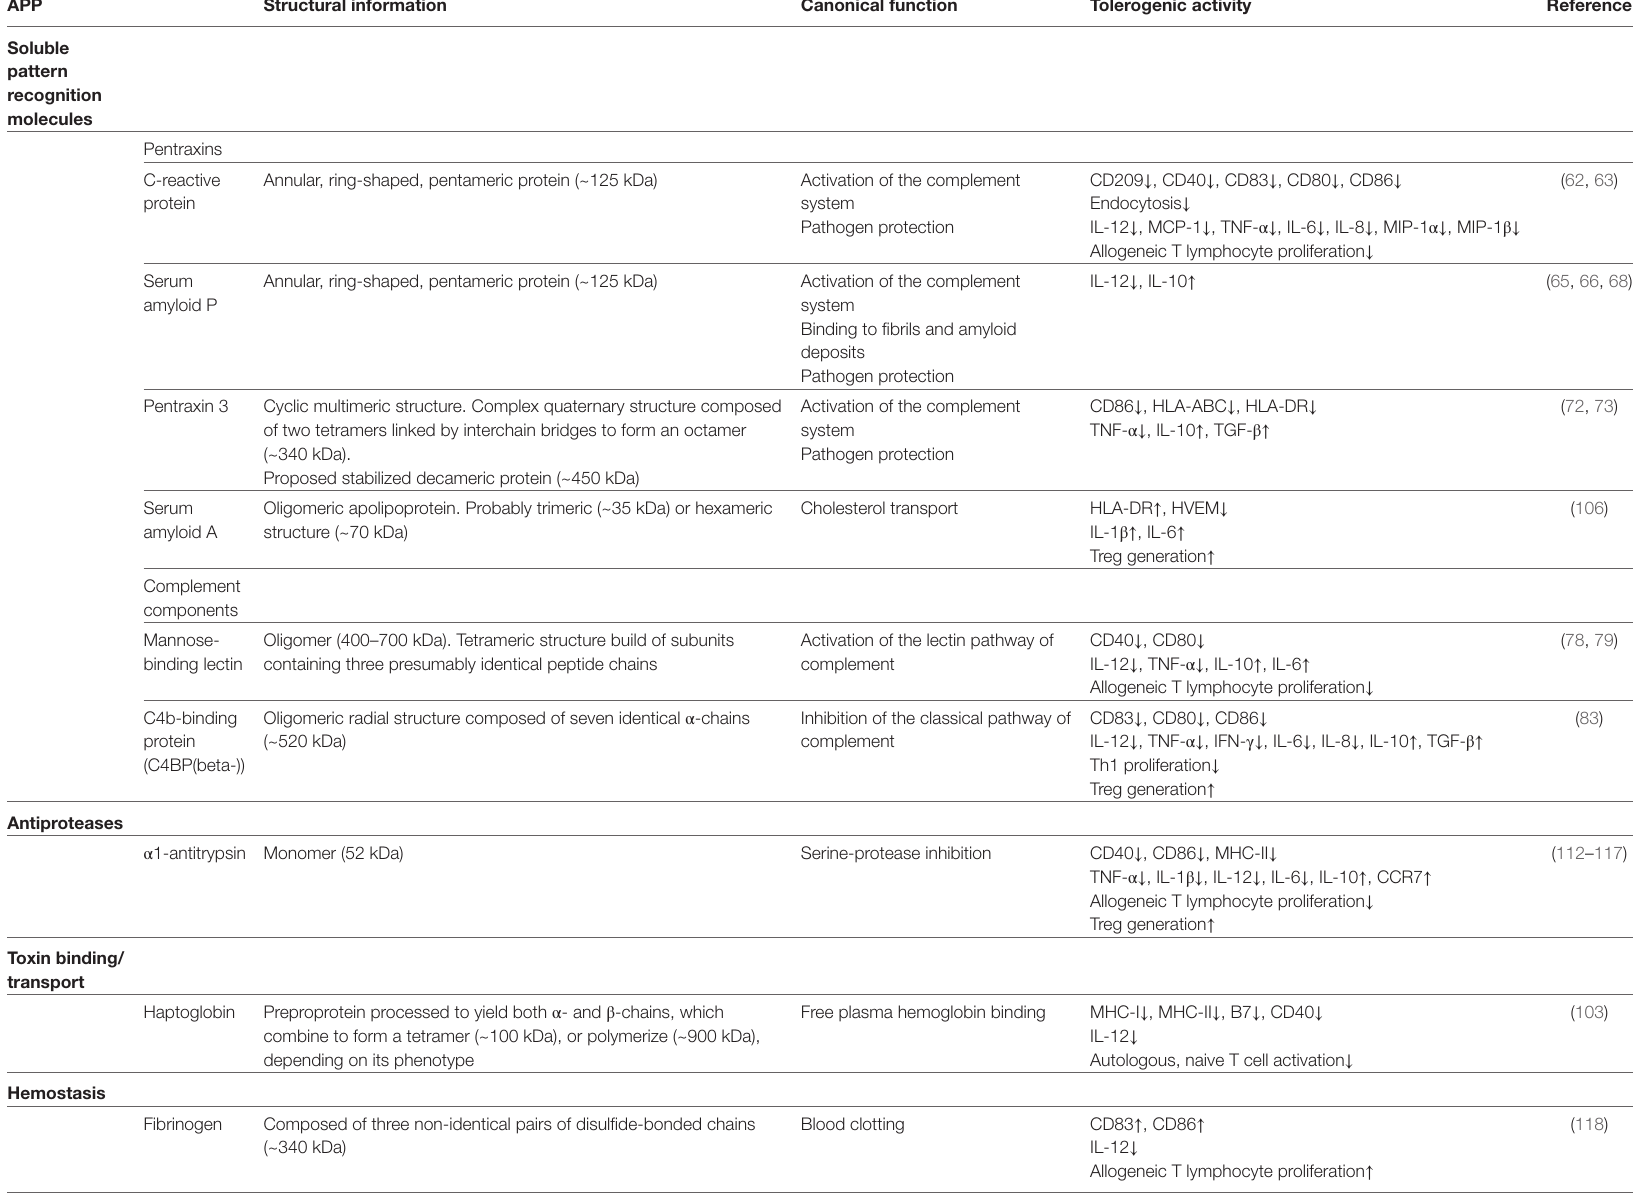
TABLe 1 | Immunomodulatory actions of acute phase proteins (APPs) on dendritic cells (DCs). APP Structural information Canonical function Tolerogenic activity Reference Soluble